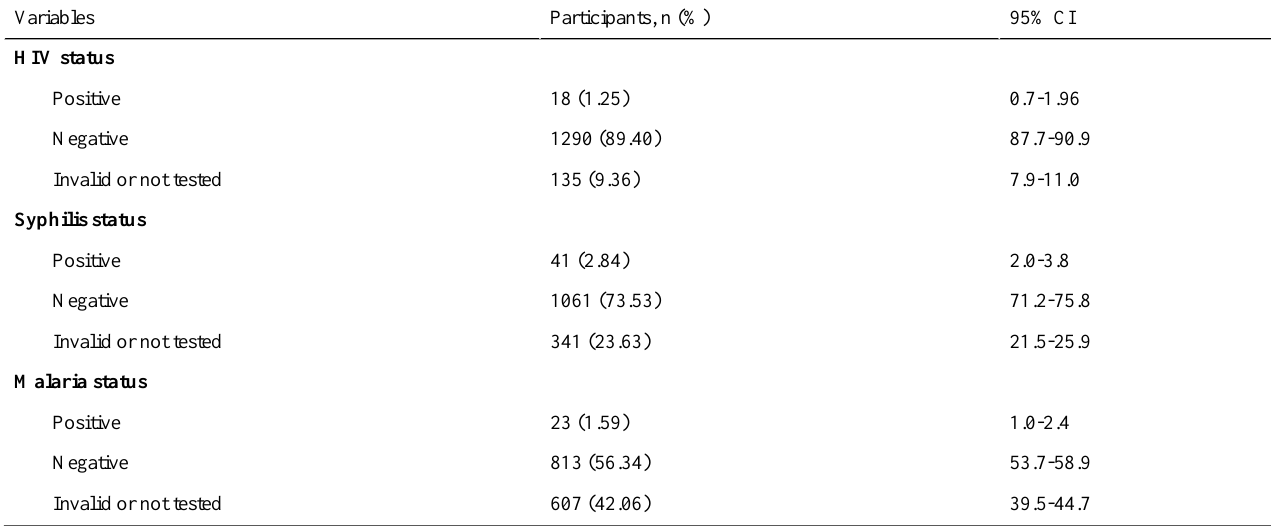
Table 1. Prevalence of malaria, HIV infection, and syphilis among pregnant women in the Ambanja district, Madagascar, from January 13, 2015, to September 20, 2019, at their first antenatal care visit (n=1443).